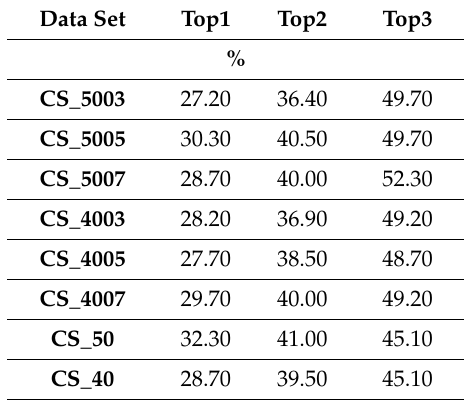
Table 3. Summary of the performance of the different CS datasets in the docking power test.